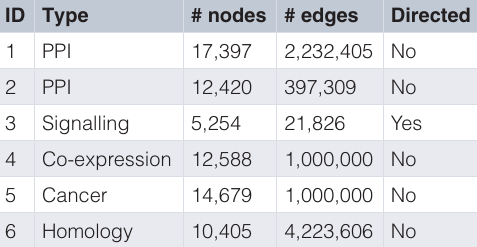
Table 1. Challenge